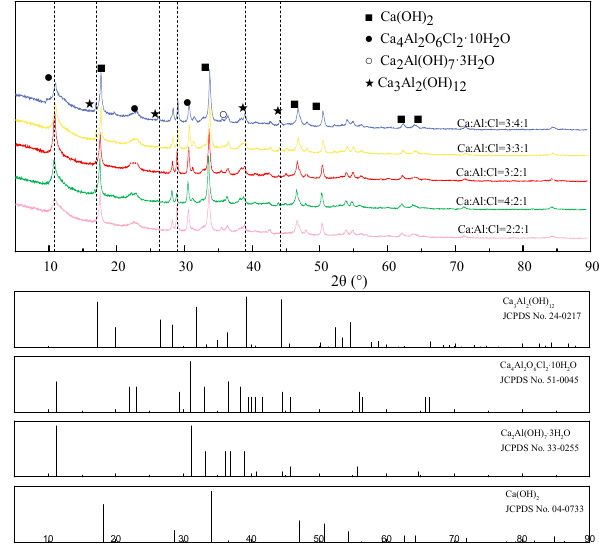
Figure 1. XRD patterns of precipitations after adsorption of chloride vs. various n (Ca:Al:Cl) ratios.